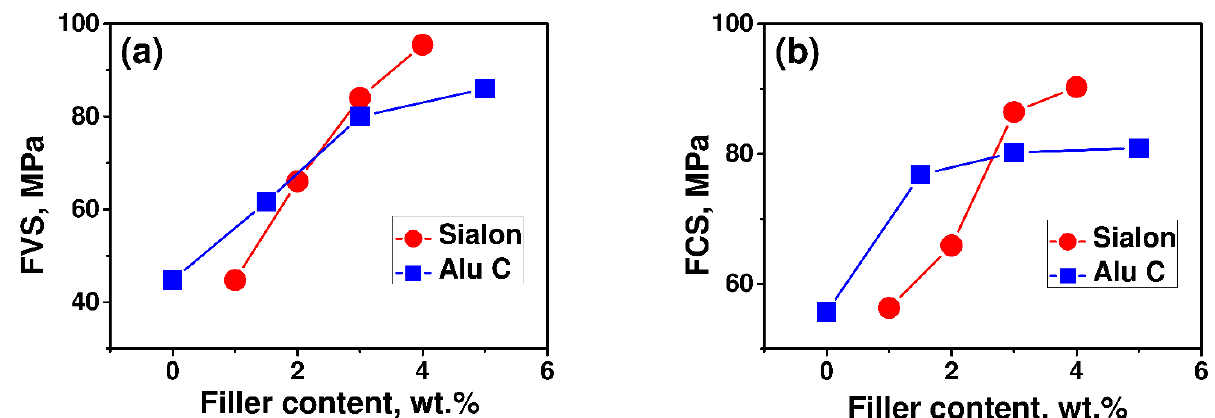
Figure 5. Scratch hardness for: ( a ) the first visible scratch (FVS) and ( b ) the first coating stripping (FCS) as a function of the Sialon and Alu C content in the coatings.